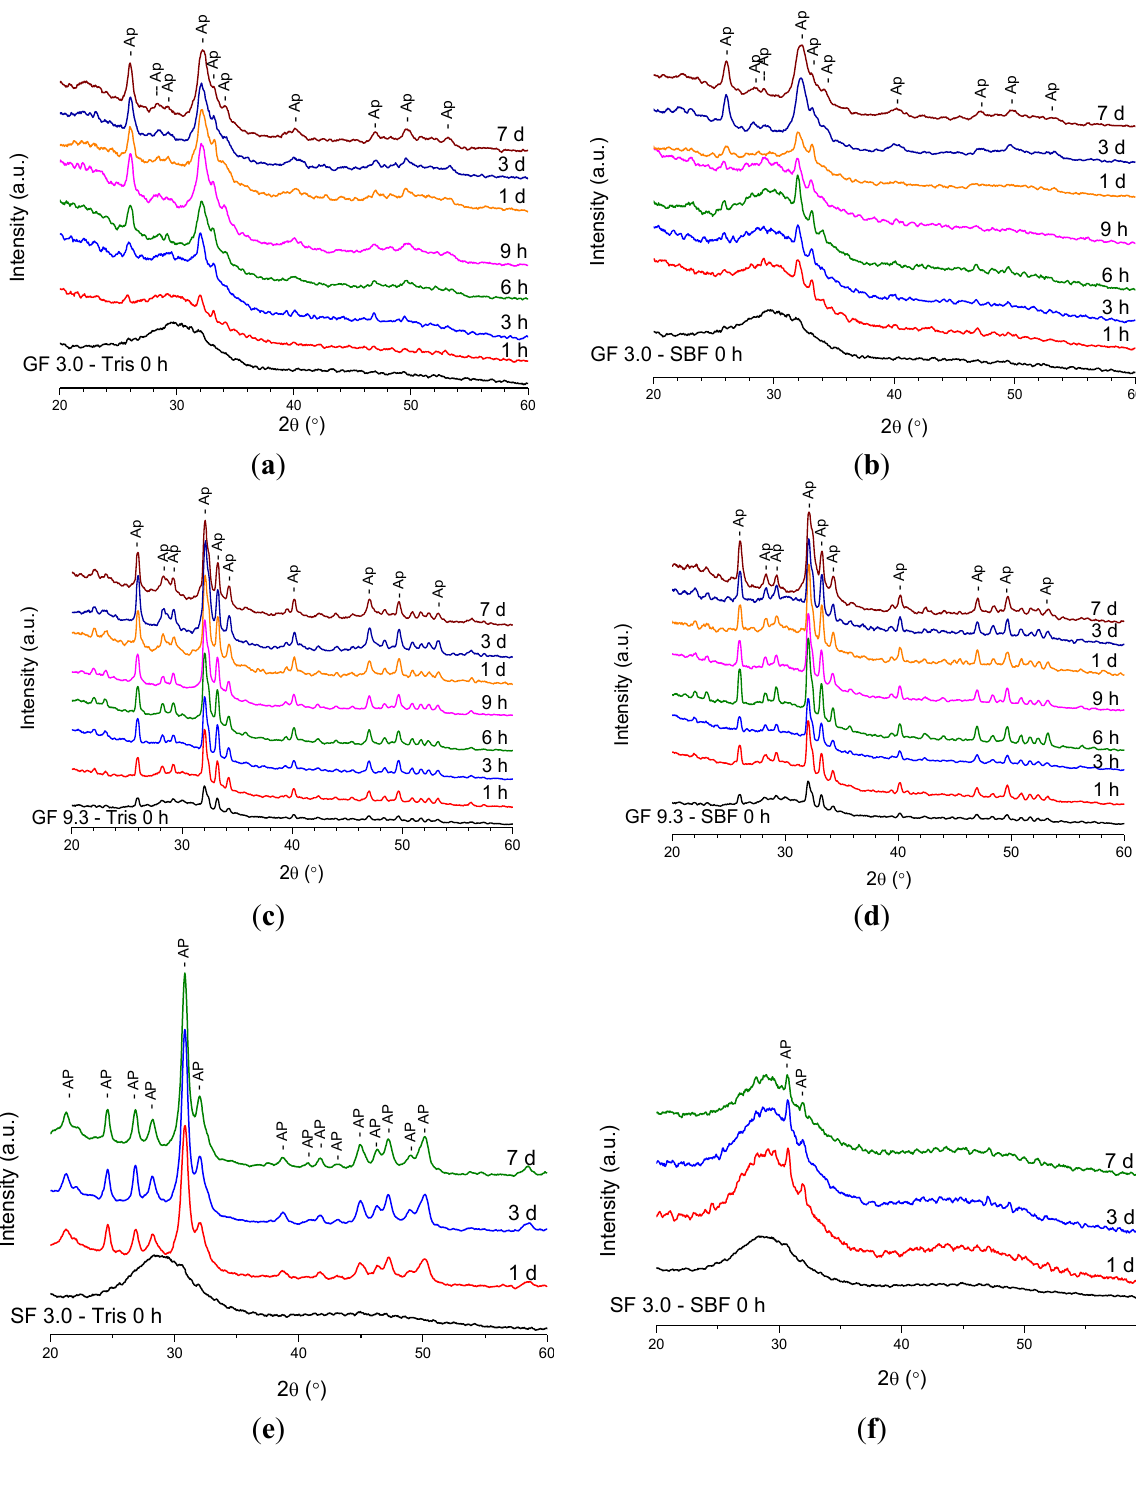
series is fluorapatite 2 (PO ) F in SrF series 5 4 3 2